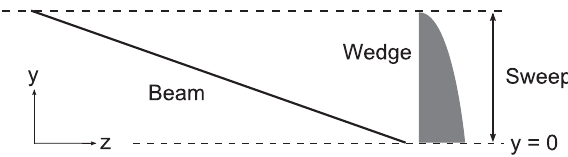
TABLE I. The amount of material through which 1 GeV = u